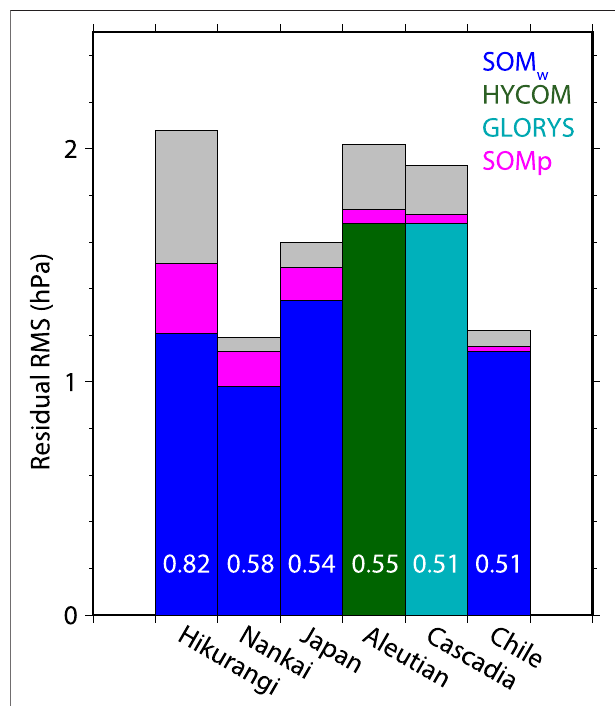
FIGURE 12 | Root-mean-square amplitudes of observed and residual ocean bottom pressure at the six subduction zones. Values are calculated as averages over the respective regions, taken from Table 3 . White numbers are correlation coef fi cients corresponding to the root-mean-square reduction rates. Gray and magenta indicate model ’ s contribution without and with SOM p , respectively. At the Hikurangi Trough, the Nankai Trough, the Japan Trench, and the Chile Trench, SOM w + SOM p is shown as the representative. At the Aleutian Trench, and the Cascadia Subduction Zone, HYCOM + SOM p , and GLORYS + SOM p are respectively the representatives.